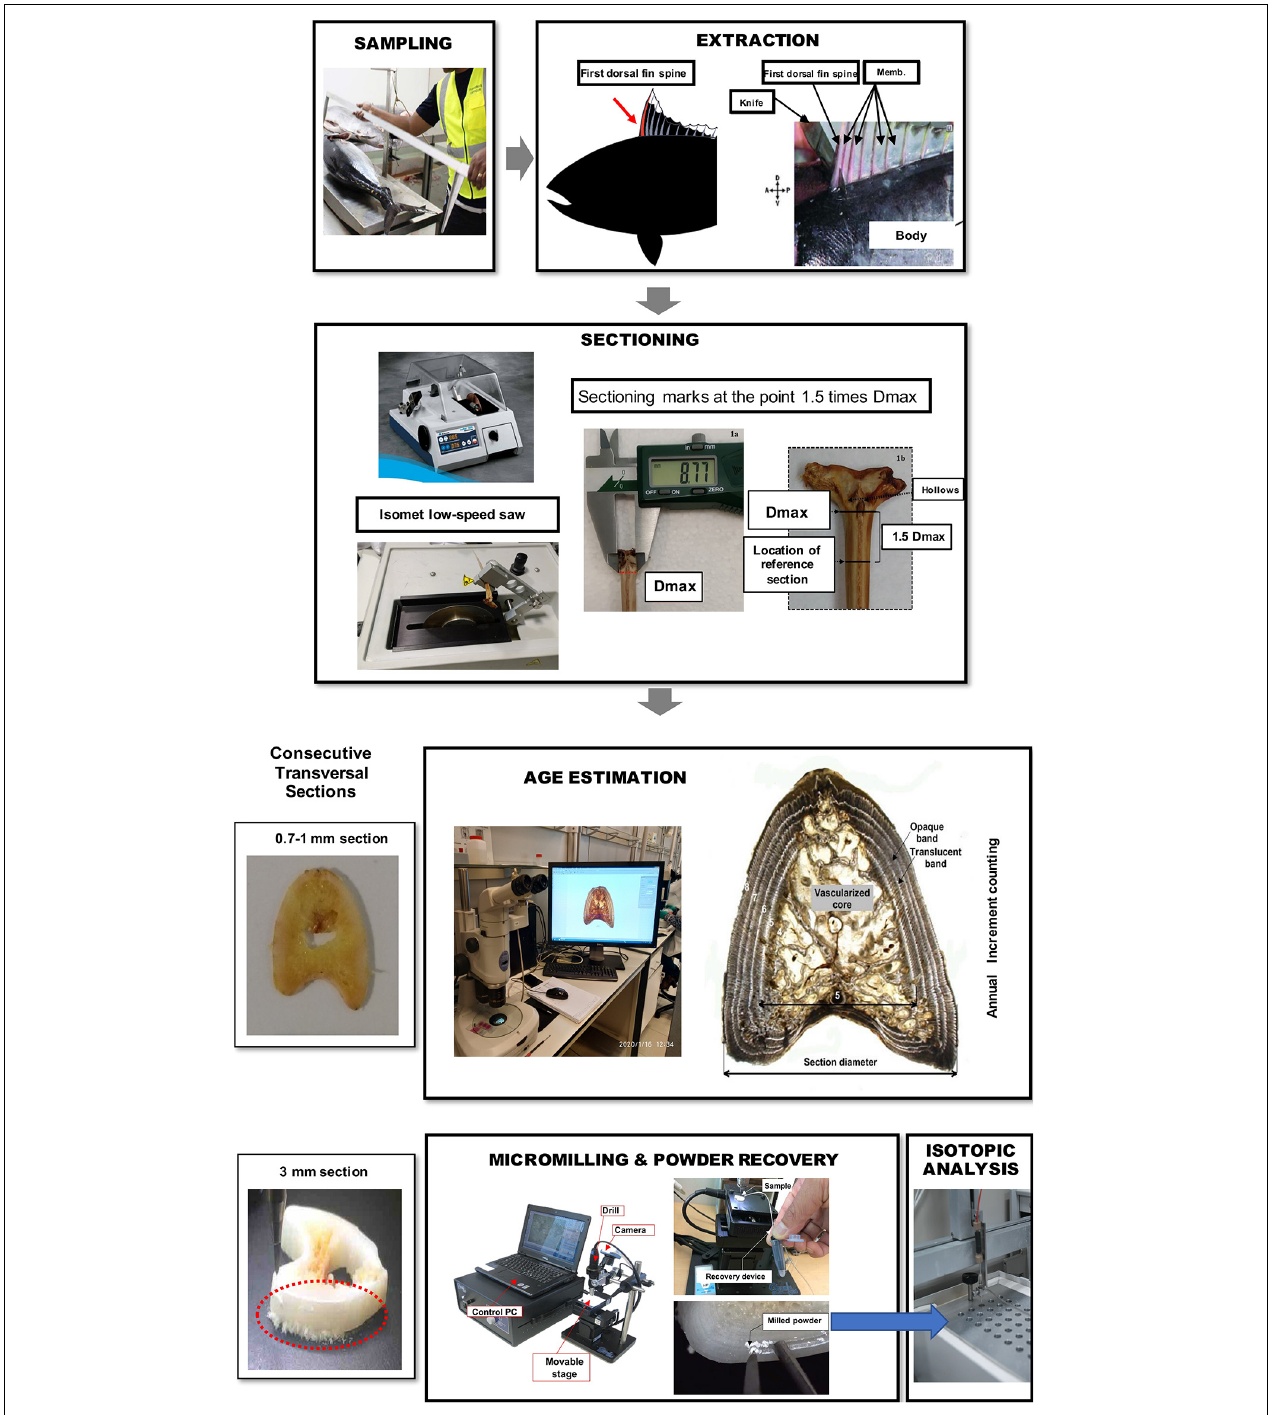
FIGURE 1 | Illustration of workflow for bluefin tuna fin spine sampling, preparation, age interpretation, micromilling, and isotopic analysis processing.